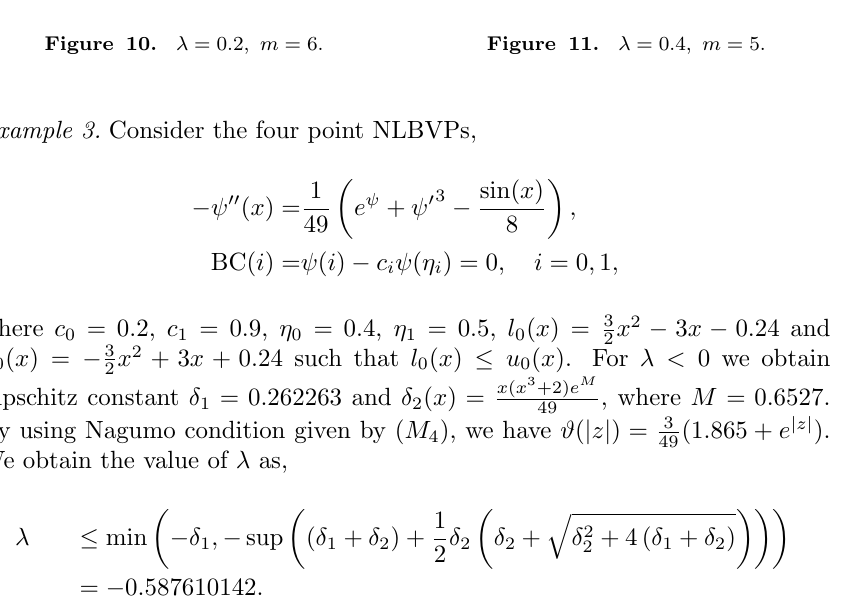
Figure 8. A 2 ( λ ) ≤ 0 . Figure 9. λ = 0 . 05 , m = 5 .